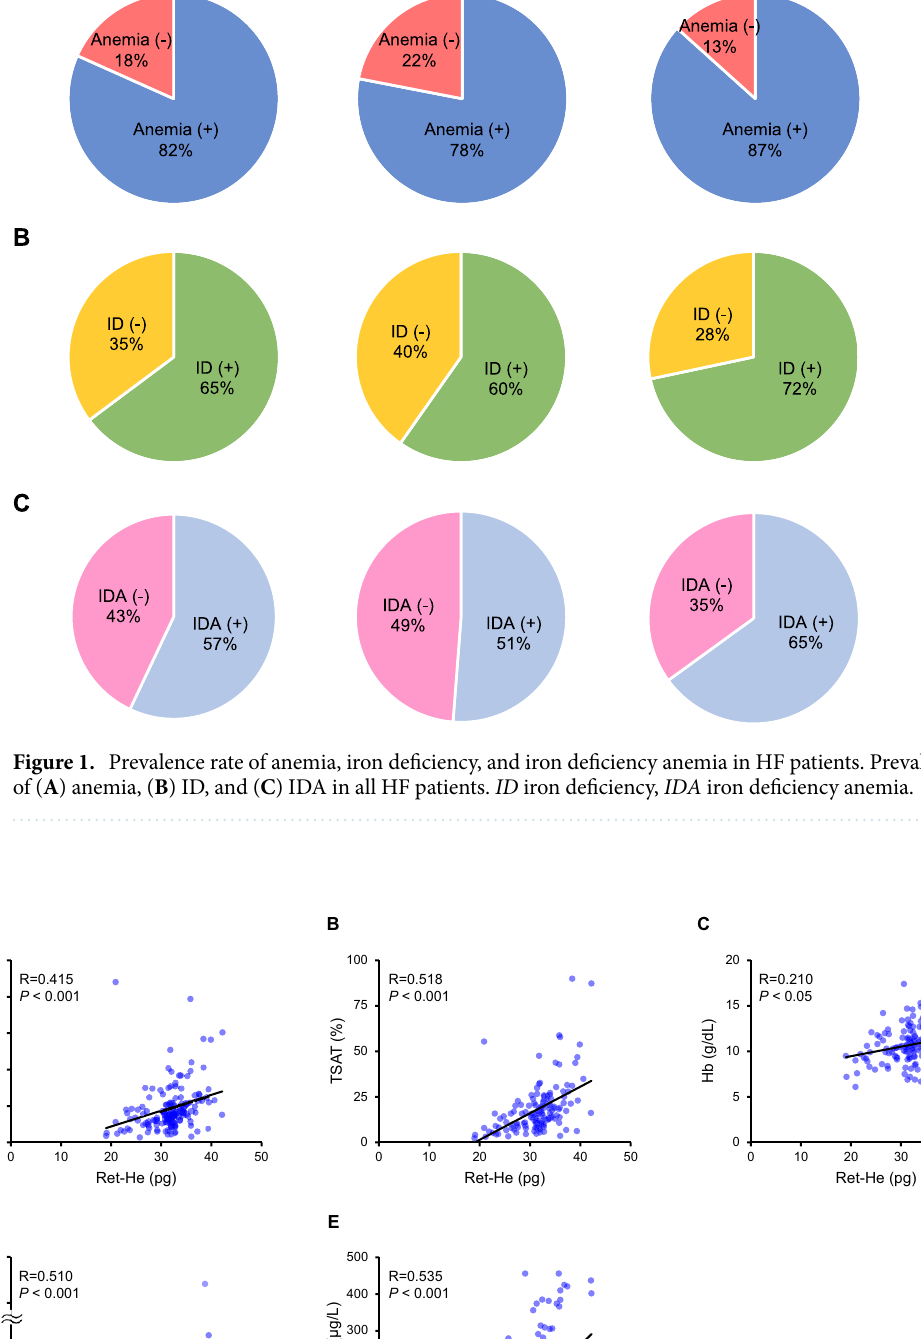
R=0.415 P < 0.001